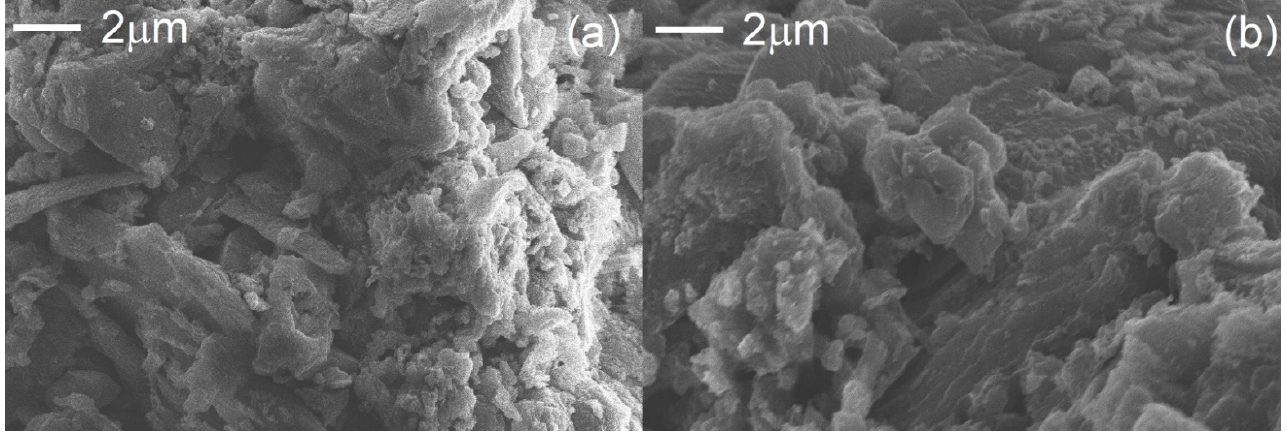
Figure 2. SEM images of the bulk ( a ) and exfoliated ( b ) g-C 3 N 4